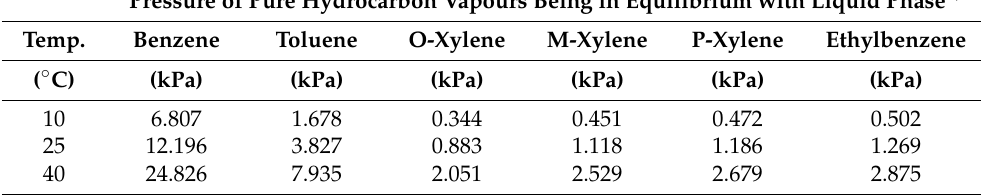
Table 3. Equilibrium vapour pressures of pure BTEX components at given temperatures.